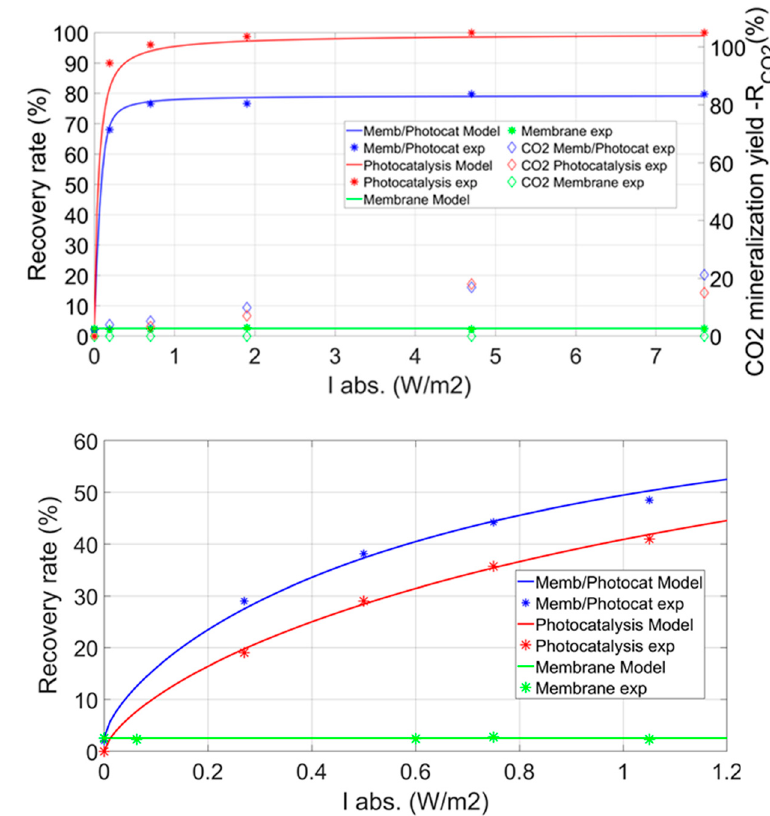
Figure 5. Toluene recovery ratio for three different configurations vs. I abs − ψ = 0.98/2 ( a ) C in = 10 ppm— Catalyst m 2 ( b ) C in = 2 ppm—Catalyst m 0 — without sweep gas.